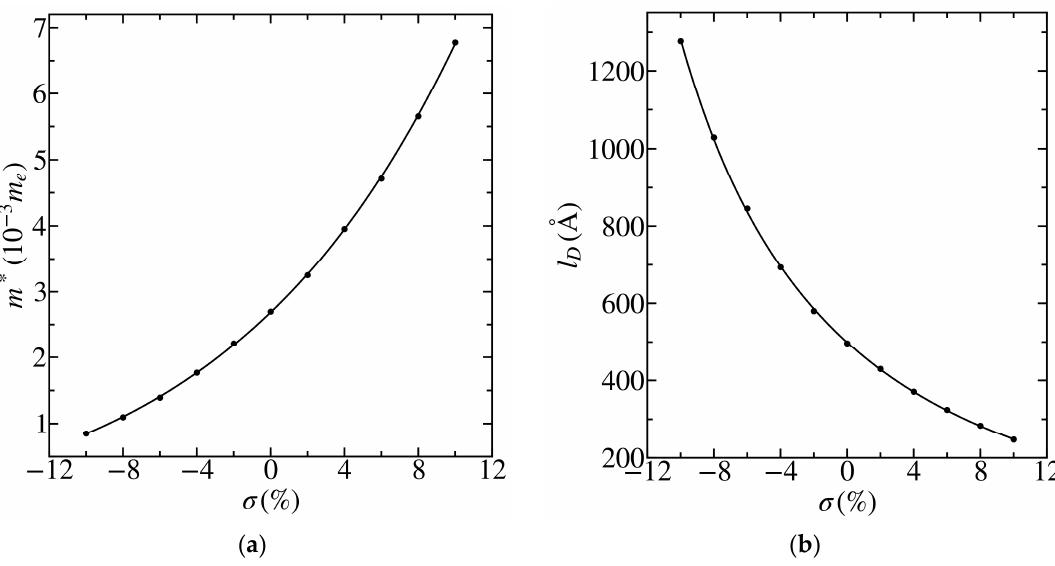
Δ ( a ) and the “Compton length” in graphene * ( a ) and the “Compton length” in graphene = m 2 v 2 D 2 2 v D v . The solid lines correspond to their least- D